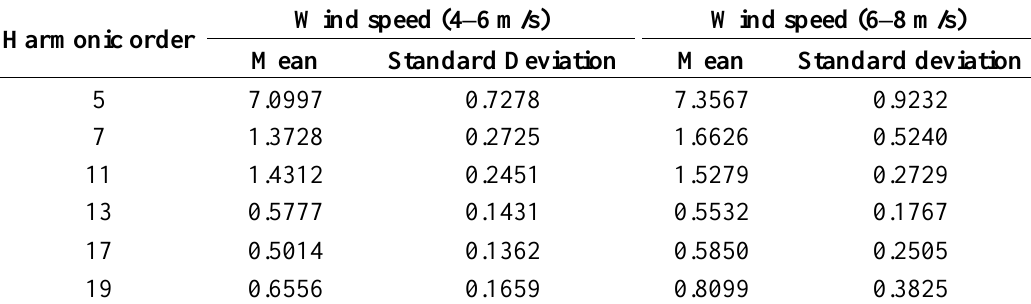
Table 4. Normal distribution parameters for the different order harmonic